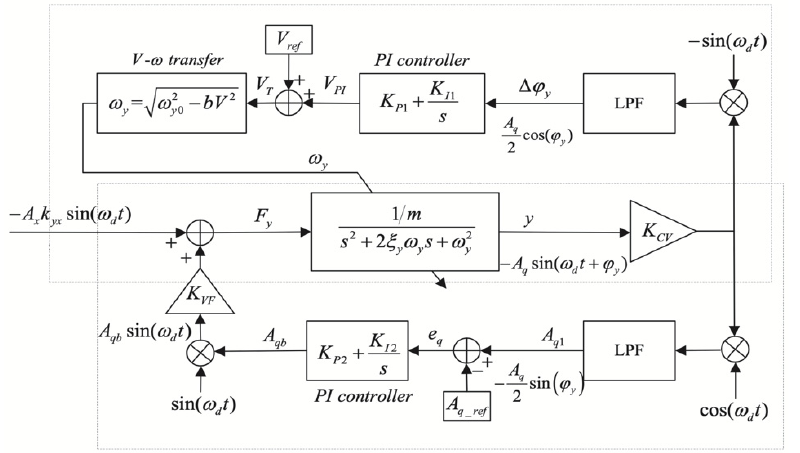
Figure 16. The framework of the mode-matching system with dual-phase and amplitude control from Soochow University.